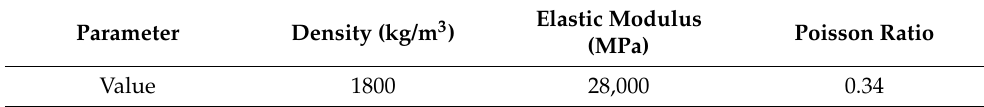
Table 4. The parameter of the 7075 aviation aluminum alloy. Parameter Density(kg/m 3 ) Value 2810 71,000 0.33